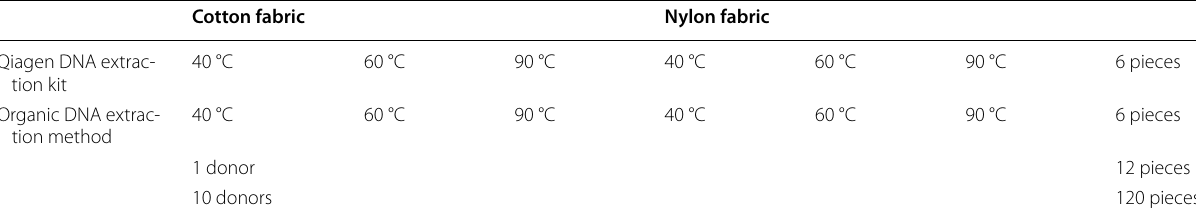
Table 1 Number of fabric samples washed and DNA extracted Cotton fabric